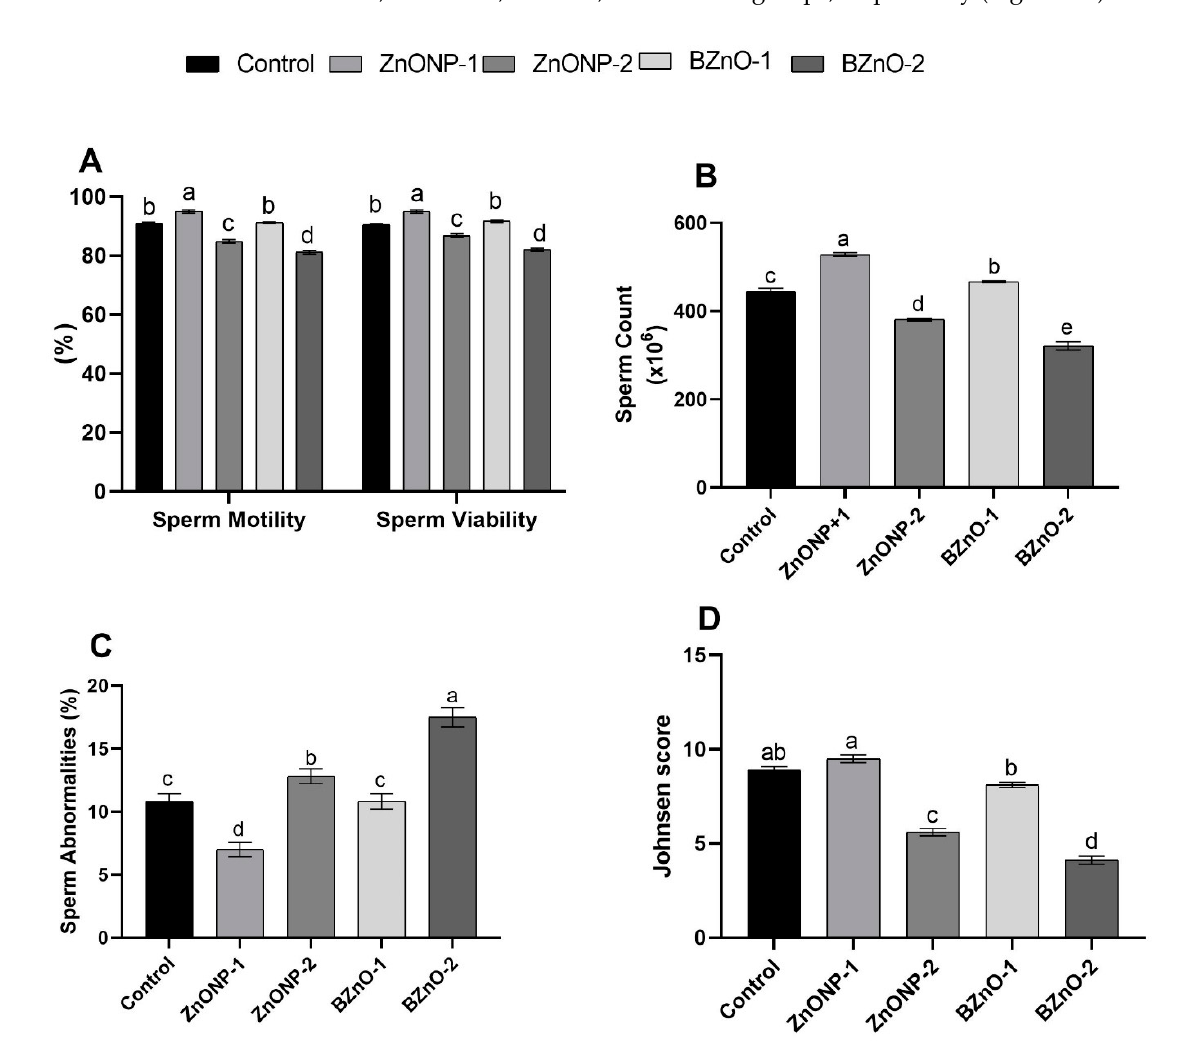
Figure 3. Effect of the ZnONPs and BZnO at different doses on the semen characteristics of male rats: ( A ) sperm motility (%) and viability; ( B ) sperm count (×10 6 ); ( C ) sperm abnormalities (%); and ( D ) Johnsen score. All the values are expressed as the mean ± SEM. Different small letters (a–e) indicate significance at p < 0.0001.